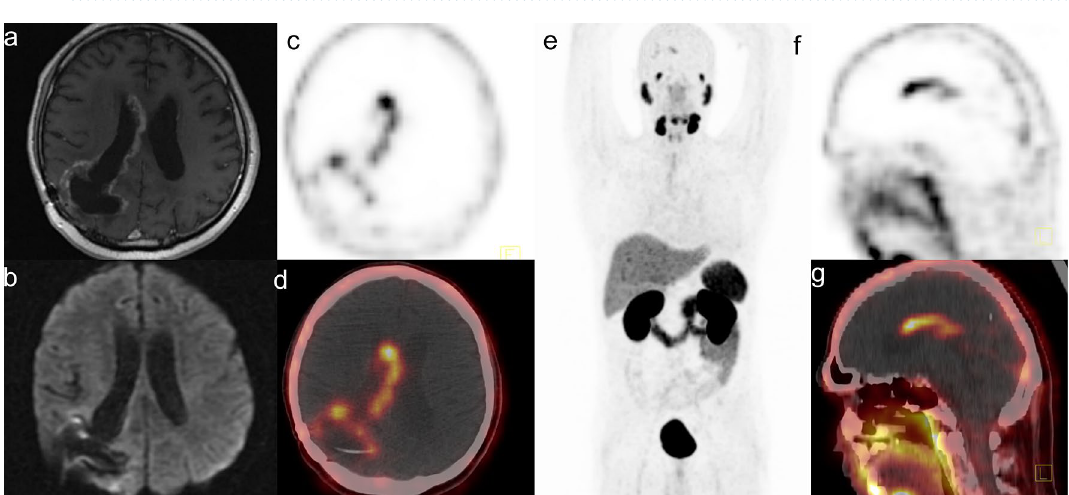
Figure 2. Female, 42 years, with a recurrent secondary glioblastoma in the right parietal lobe. Initially, she was diagnosed with glioma tumor grade II and underwent surgery. A follow-up MR revealed a contrast- enhanced mass around the surgical cavity 119.2 months after primary treatment. PET/CT showed high [ 68 Ga] Ga-PSMA-11 accumulation in the tumor; with the SUV max 17.4, SUV mean 7.4, TBR 870 and TLR 3.4 ( a — contrast-enhanced T1WI, b —DWI, c —PET transverse image, d —fused PET/CT transverse image, e —maximal intensity projection, f —PET sagittal image, g —fused PET/CT sagittal